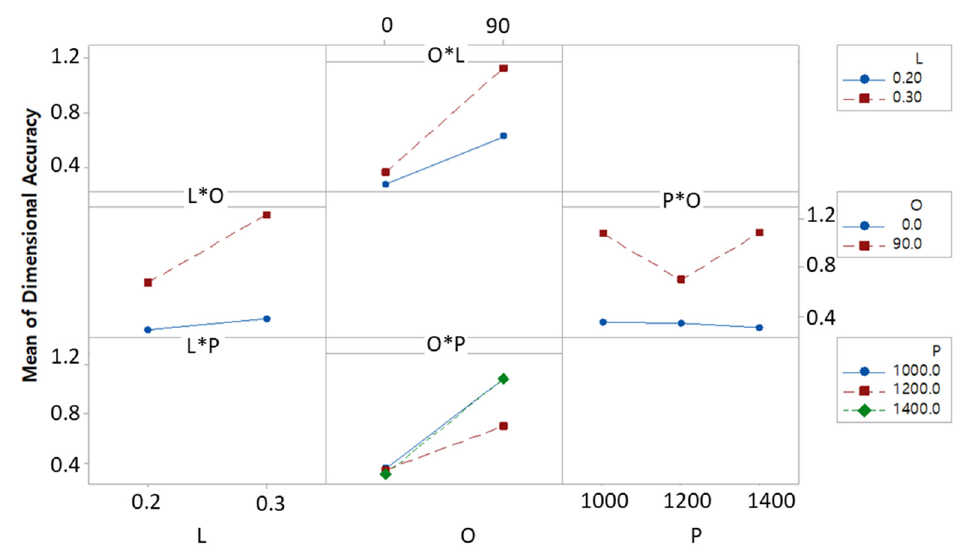
Figure 7. Main effect plots of the significant factors for dimensional accuracy. ( a ) ASTM D638; ( b ) ASTM D695; ( c ) ASTM D3039.